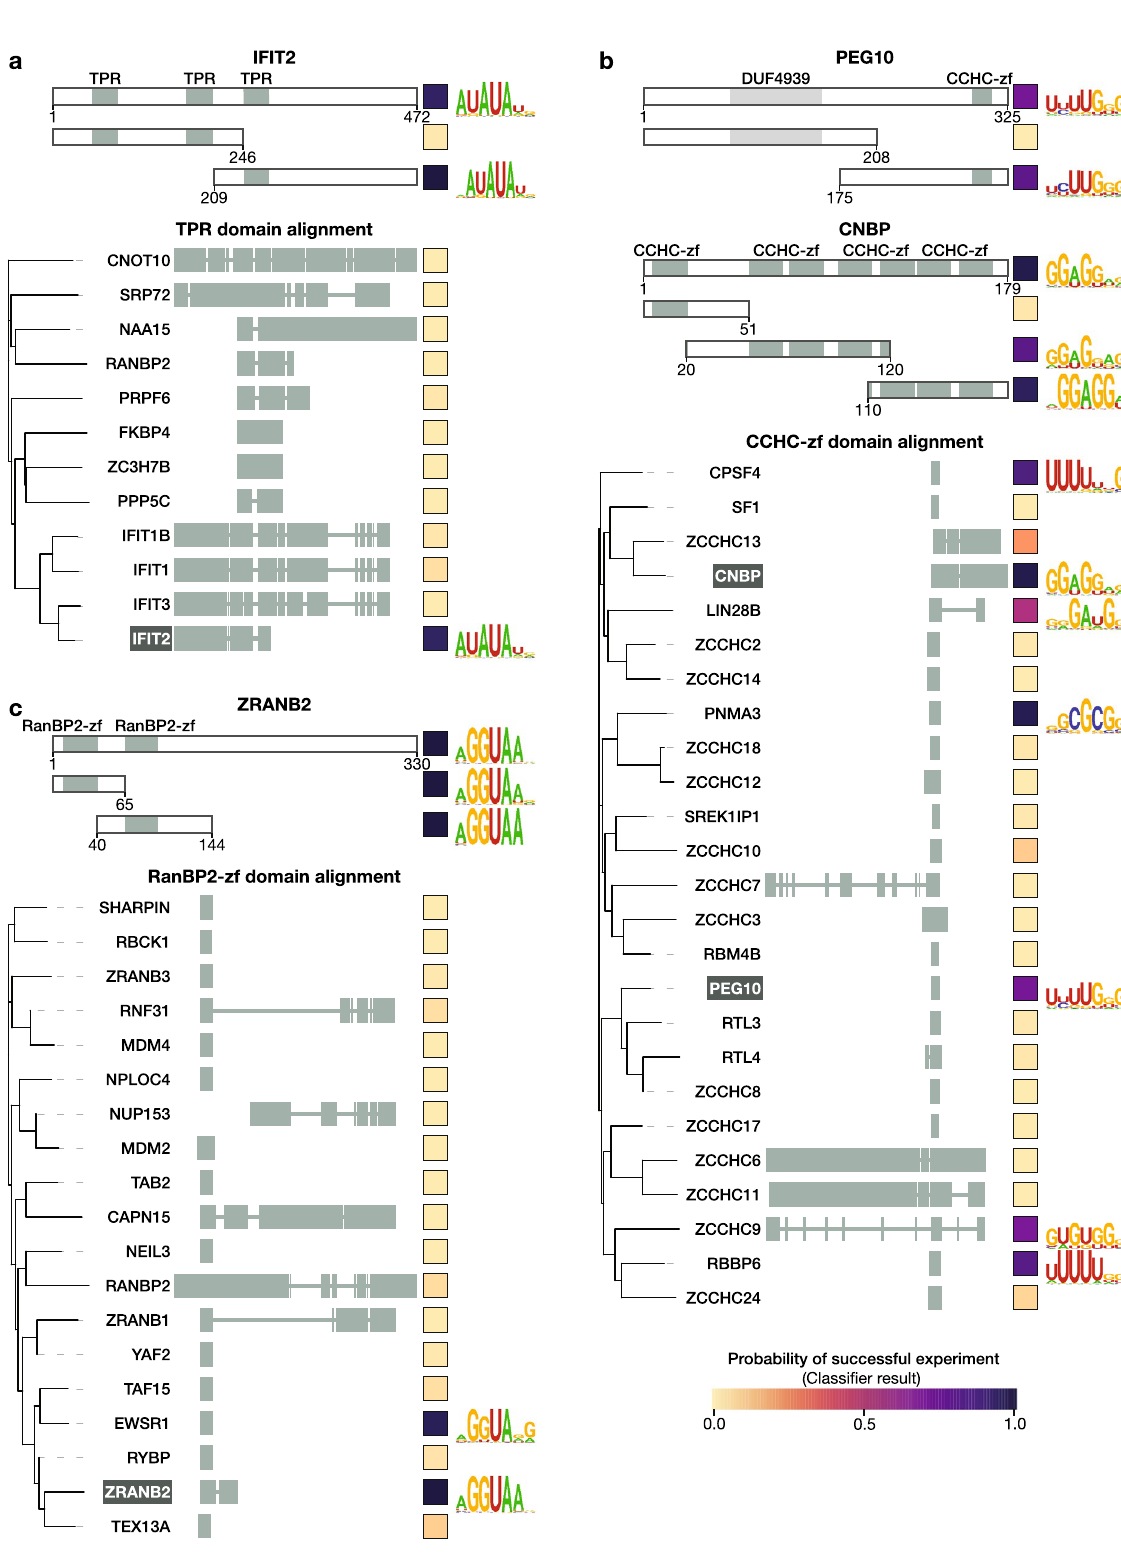
Figure 4. RNA-binding specificity of putative ucRBDs (Part II). Representative ucRBPs identified in this study for selected ucRBDs—( a ) TPR, ( b ) CCHC-zf, and ( c ) RanBP2-zf—are shown at the top. Below these are depictions of deletion constructs used to identify corresponding ucRBDs with sequence-specific RNA-binding. ucRBPs listed below the ucRBD “domain alignment” heading depict ucRBD only constructs analyzed by RNAcompete. Clustal Omega 82 was used to generate phylogenetic trees; visualizations were created with iTOL 88 . Square boxes to the right of each construct display the classifier score indicating the probability of a successful RNAcompete experiment. Logos are provided for ucRBPs/ucRBDs with sequence-specific RNA-binding